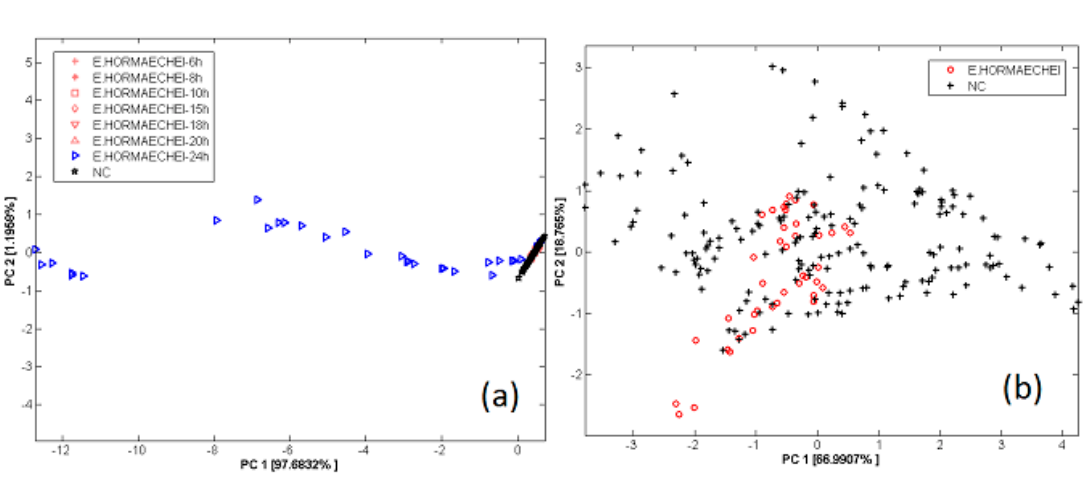
Figure 17. ( a ) PCA score plot of EN patters of samples not contaminated (NC) and contaminated by E. hormaechei detected in 24 h; ( b ) PCA score plot of EN patters of samples not contaminated (NC) and contaminated by E. hormaechei incubated for 6 h to 20 h (zoom of previous PCA reported in Figure ( a )). Reprint from [120], copyright (2014) with permission from Elsevier.